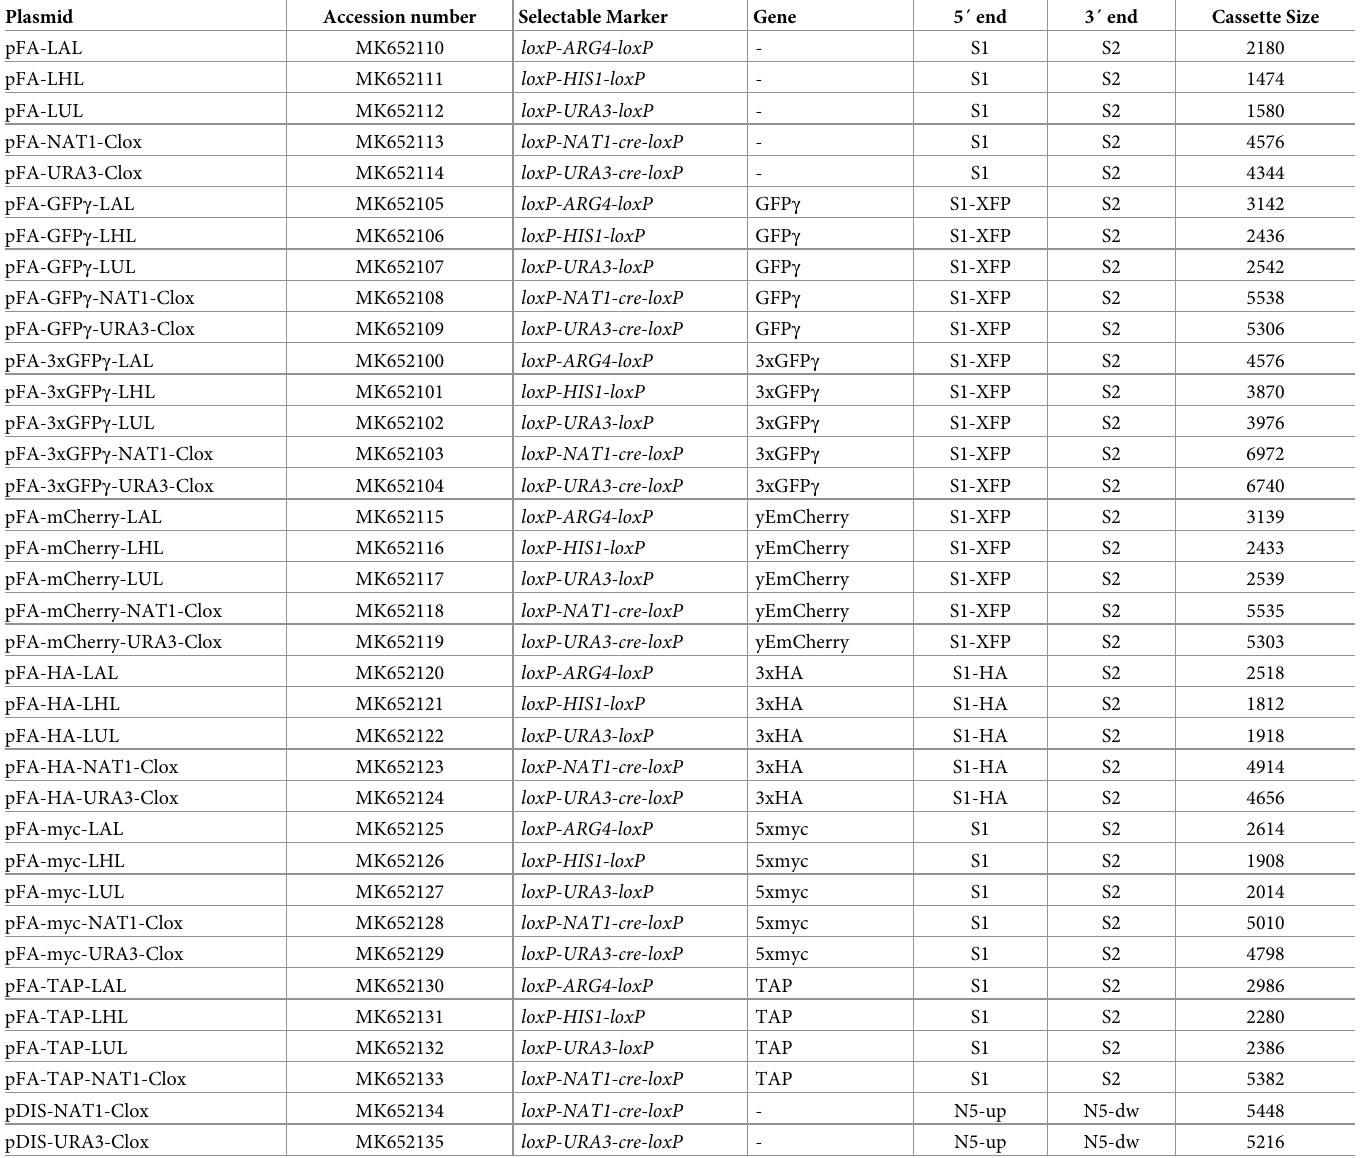
Table 1. The pFA- Clox toolkit. Plasmids generated and fragment length of the cassettes.